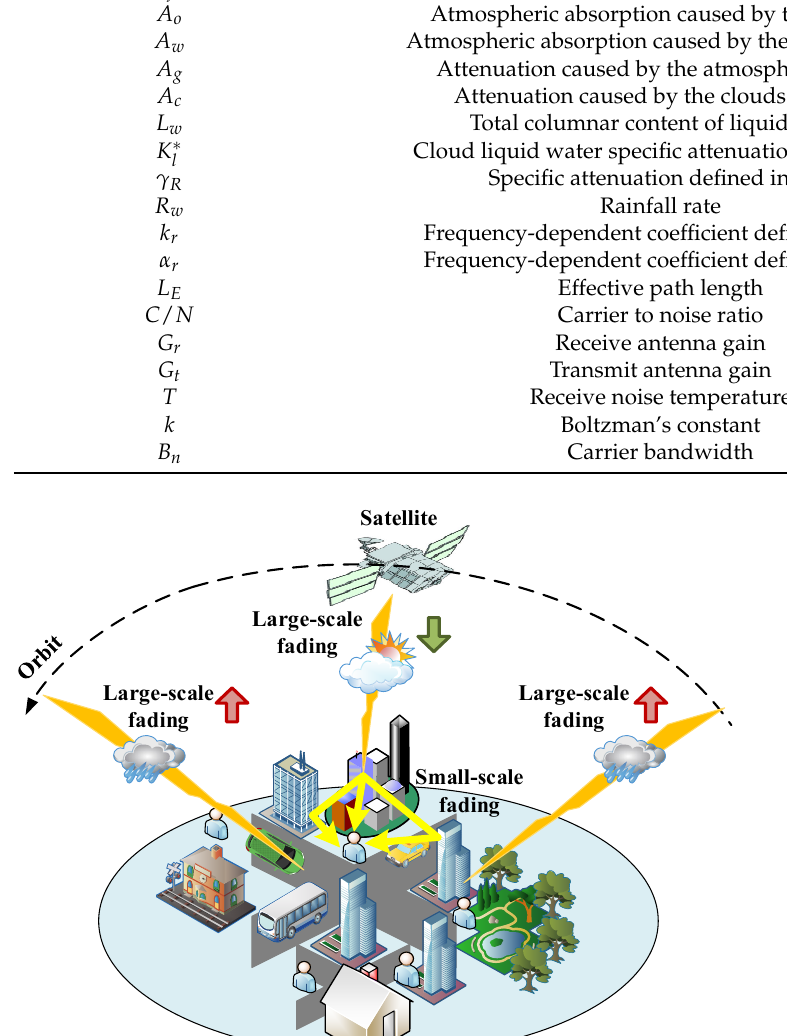
Figure 1. The information is transmitted from the LEO satellite to the ground user. The large-scale fading between the LEO satellite and the ground user is mainly caused by two aspects. On the one hand, due to the mobility of the LEO satellite, the distance d and elevation angle ϕ between the satellite and the ground user are time-varying in a communication window. Therefore, the free-space path loss changes dynamically. On the other hand, when LEO satellites operate at higher frequency bands, the attenuation caused by different weather cannot be